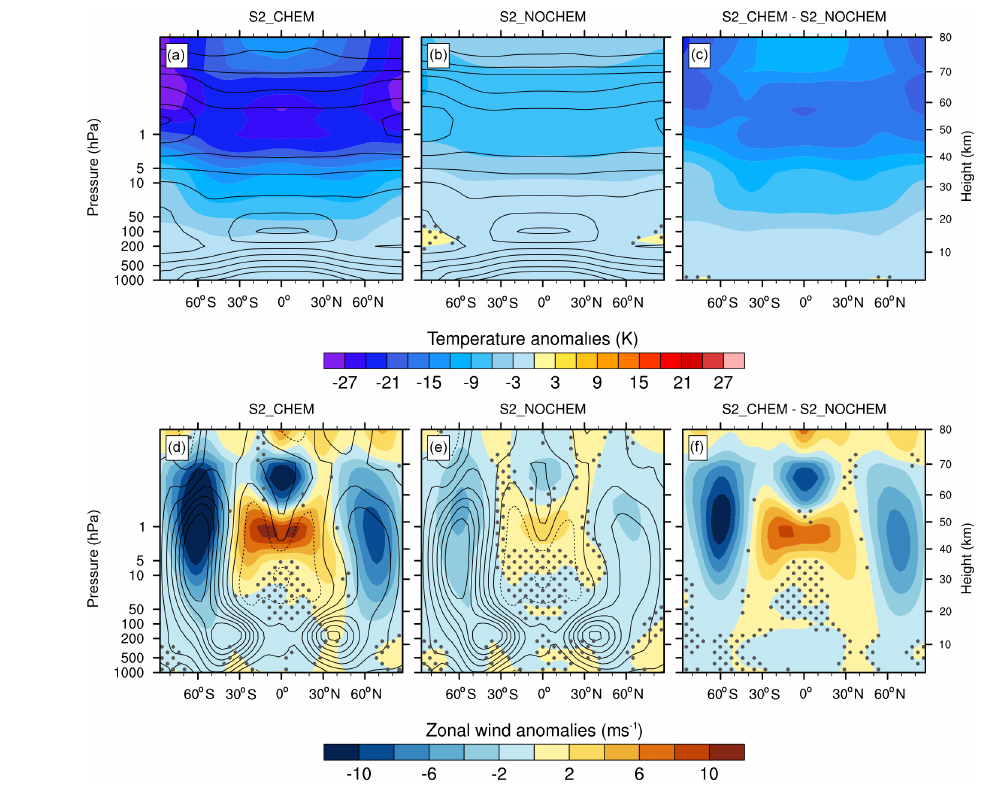
Figure 5. Annual mean zonal mean temperature (a–c) and annual mean zonal mean zonal wind (d–f) anomalies in the S2 experiments relative to the control experiments: panels (a) and (d) show the anomalies for the S2_CHEM experiment and (b) and (e) the results for S2_NOCHEM. The differences between both experiments (S2_CHEM – S2_NOCHEM) are shown in (c) and (f) . Anomalies are averaged over the 30-year SRR period. Contours represent the mean state in the control experiments with contours from 180 to 280K (contour step 15K) for the temperatures and − 30 to 30ms − 1 (contour step 5ms − 1 ) for the zonal wind. Dots denote non-significant temperature differences (Student’s t test, p >